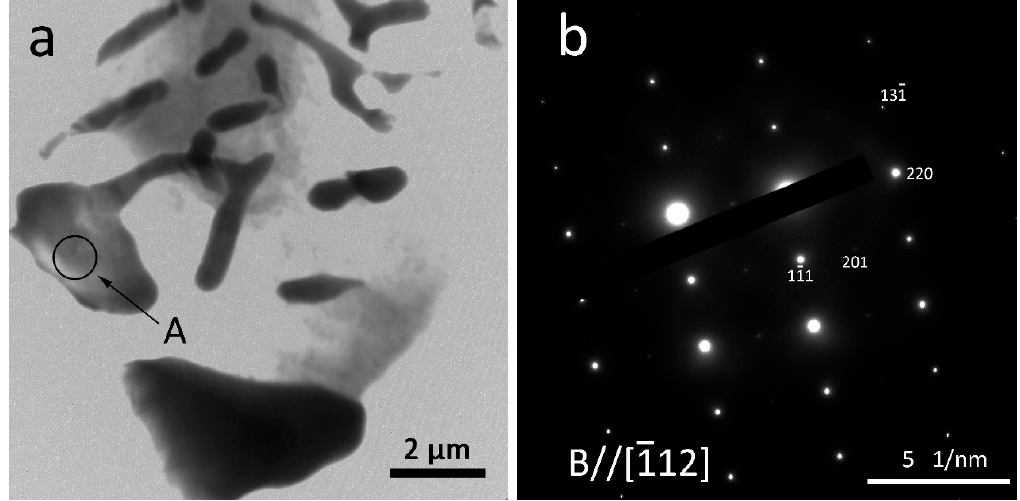
Figure 5. ( a ) A bright field transmission electron microscope (TEM) image of as-cast Mg–4Sm–2Zn– 0.5Zr alloy and ( b ) the SAED patterns taken from the position A in Figure 4a, the zone axis is [1(cid:3364)12] .